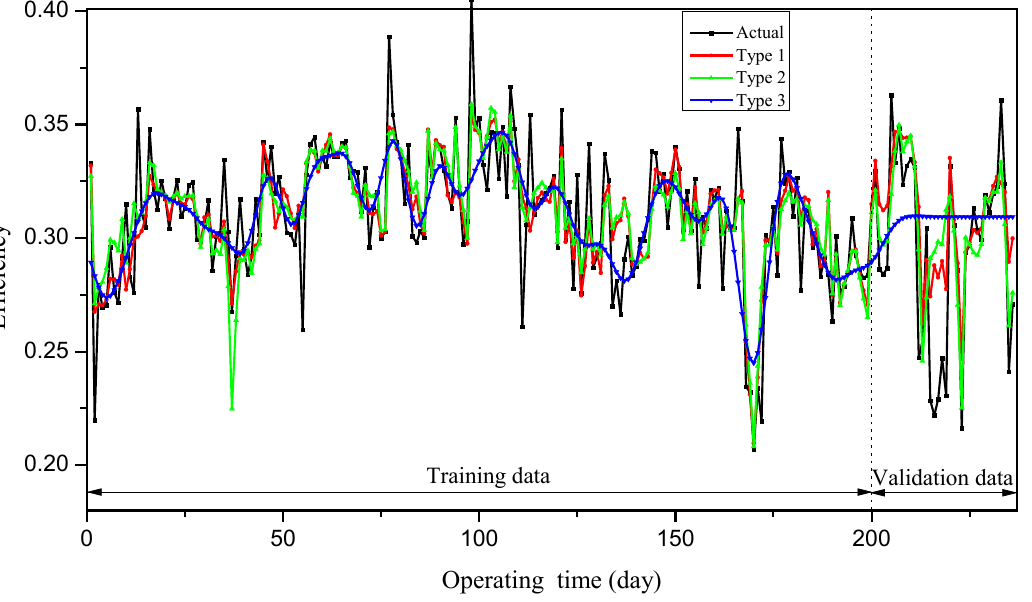
Figure 6. The comparison among the three types of model inputs.